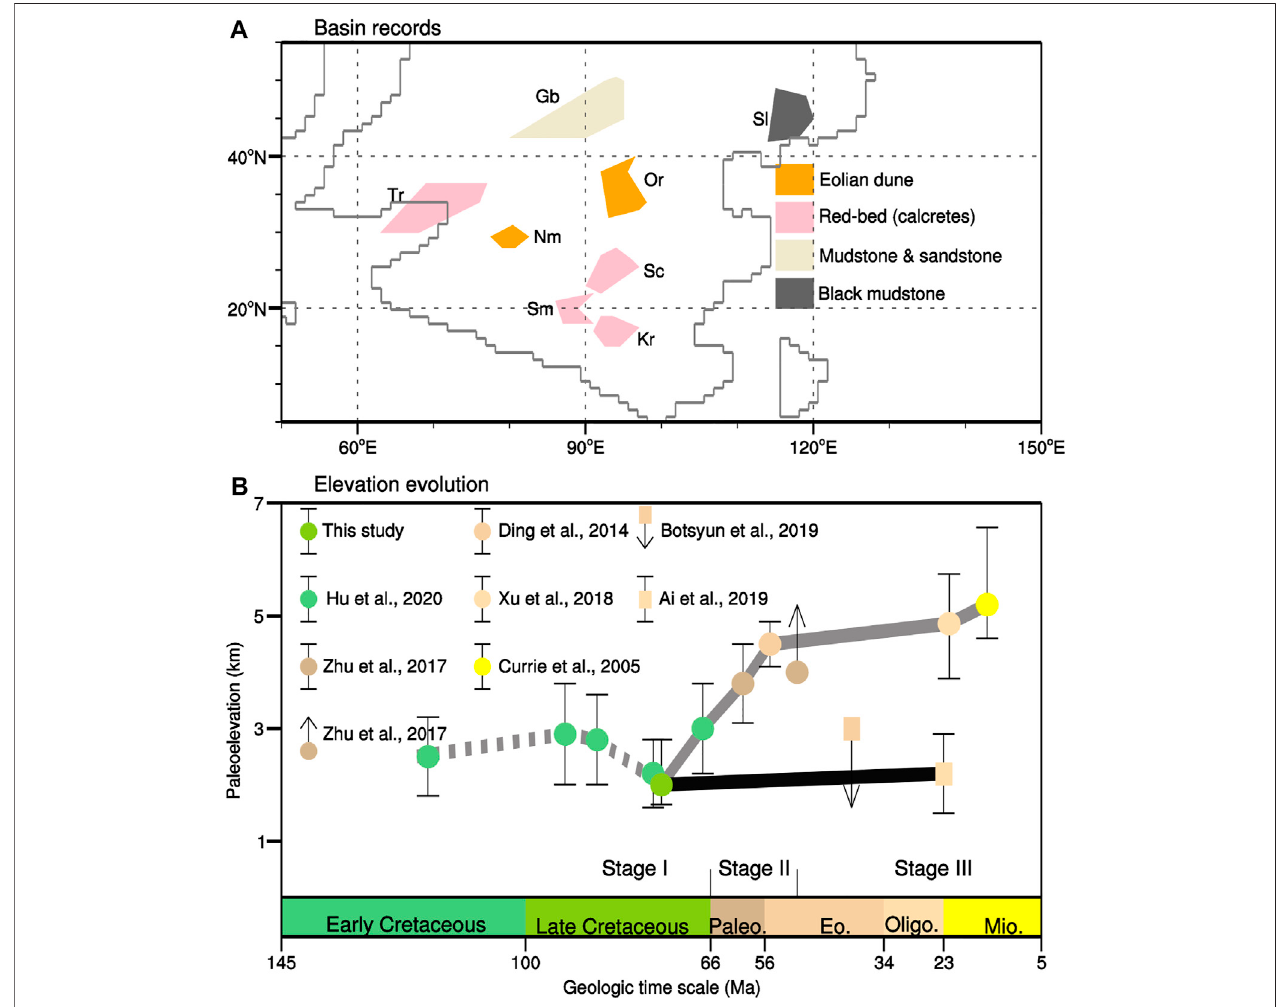
FIGURE6 | The sedimentary records inmid-to low-latitude Asian basins (A) , and evolution ofthe Gangdese Mountains from Cretaceous toMiocene (B) . In B, The dashed line represents the relatively stable stage of the Gangdese Mountains with a medium height from the Early Cretaceous to Late Cretaceous based on our result and Hu et al. (2020), the dots with error bars from Paleocene to Miocene are from Ai et al. (2019), Currie et al. (2005), Ding et al. (2014), Khan et al. (2014), and Xu et al. (2018), and the dotted data with arrow represents the least elevation (Zhu et al., 2017) or the highest elevation (Botsyun et al., 2019).